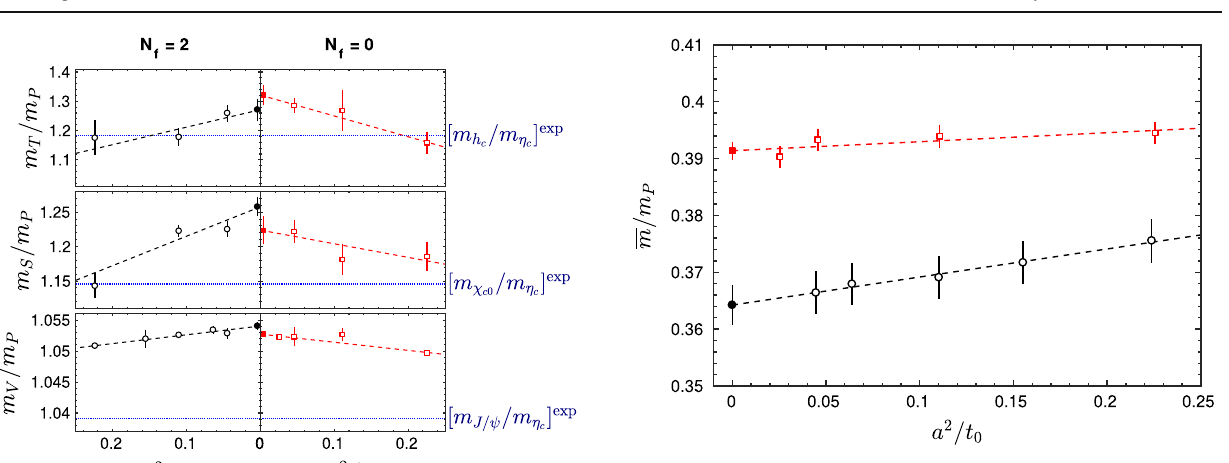
Fig. 7 Continuum limits of the renormalized quark masses in the SF- scheme divided by the pseudoscalar meson mass. Note that the quark masses in N f = 2 and N f = 0 theories are renormalized at different renormalization scales and cannot be compared directly Table 4 Results for various quantities in the continuum limit for both the N f = 0 and the N f = 2 theory Quantity N f =